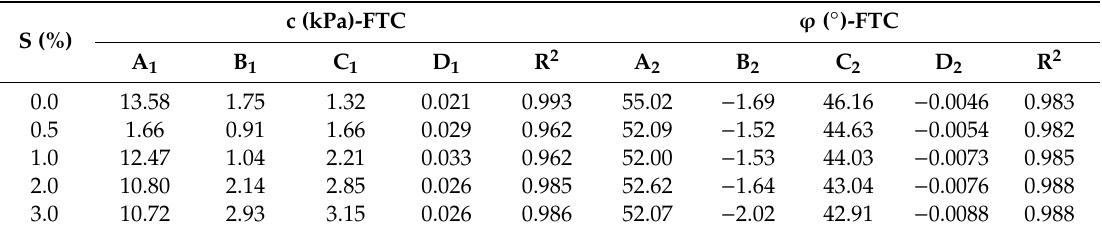
Table 5. Parameters of exponential and Fourier functions that can reflect relationship between c, ϕ , and FTC under di ff erent